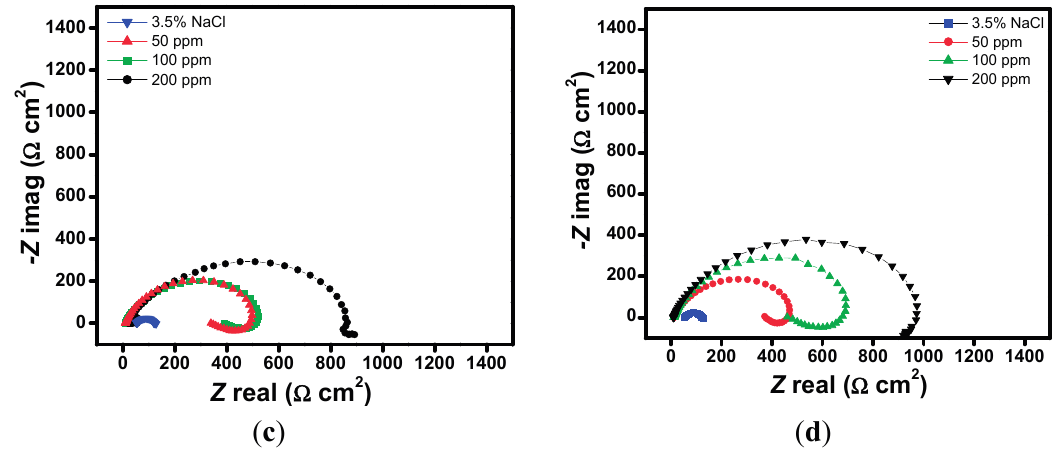
Figure 2. Nyquist plots of N80 steel in 3.5% NaCl saturated with CO 2 without and with various concentrations of ( a ) HPTB; ( b ) T4PP; ( c ) THP and ( d ) TPP.